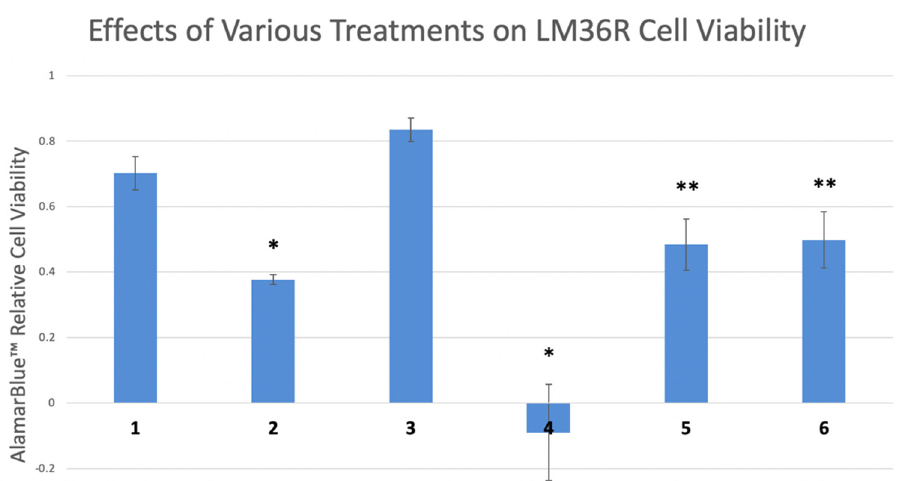
Figure 8. Relative cell viability of LM36R cells treated with certain compounds. Lanes: (1) Control (2) Indolium 1 (1 µM) (3) MEK Inhibitor U0126 (10 µM) (4) Akt Inhibitor II (10 µM) (5) Indolium 1 (1 µM) + MEK Inhibitor U0126 (10 µM) (6) Indolium 1 + Akt Inhibitor II (10 µM). * = Statistically significant lower cell viability compared to control ( p < 0.05). ** = Statistically significant lower cell viability compared to control and statistically higher cell viability than Indolium 1 treatment (lane 2) alone. Inhibition of MAPK and AKT reverses cell death caused by Indolium 1.